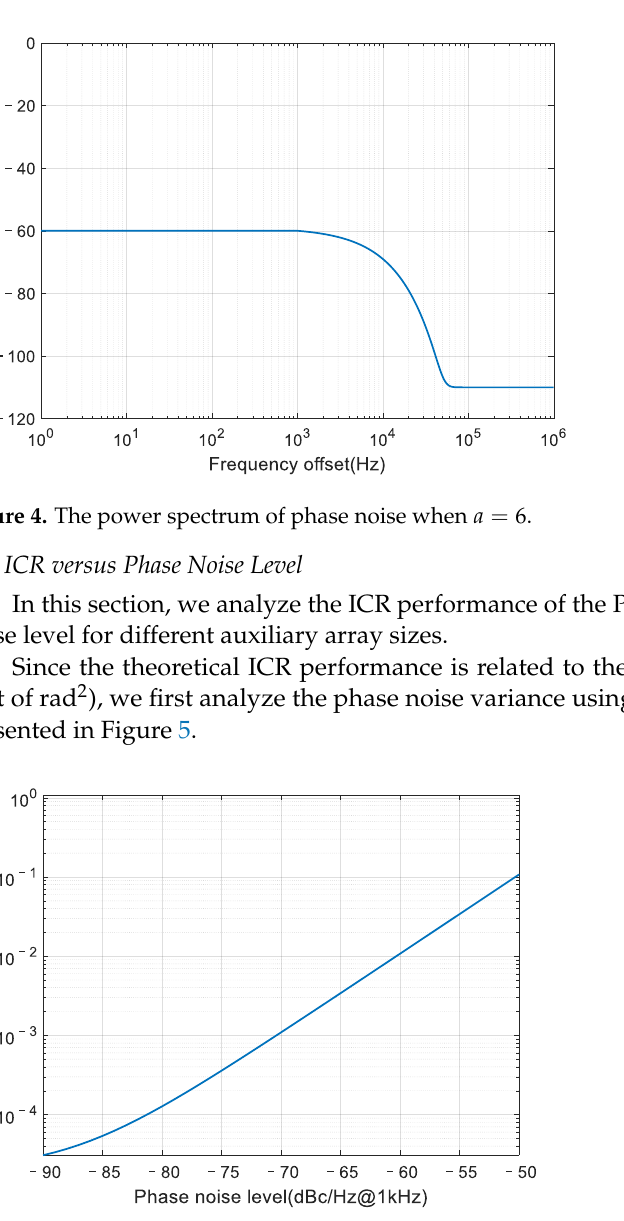
Figure 5. Relation between the variance and power spectrum of phase noise.